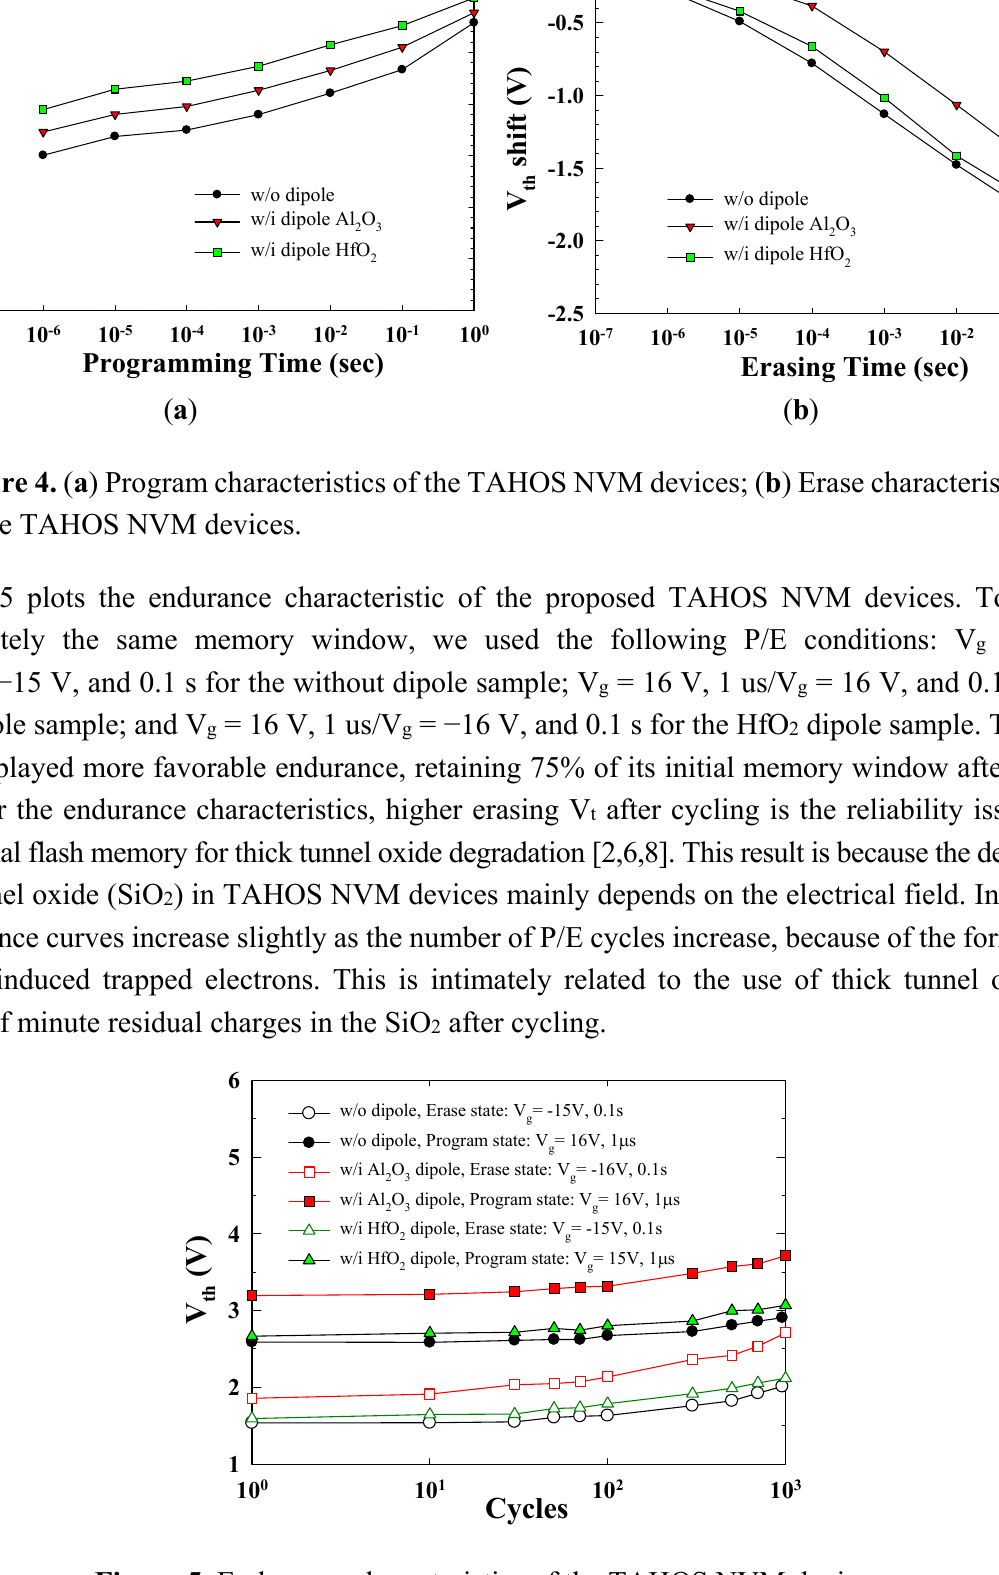
Figure 5. Endurance characteristics of the TAHOS NVM